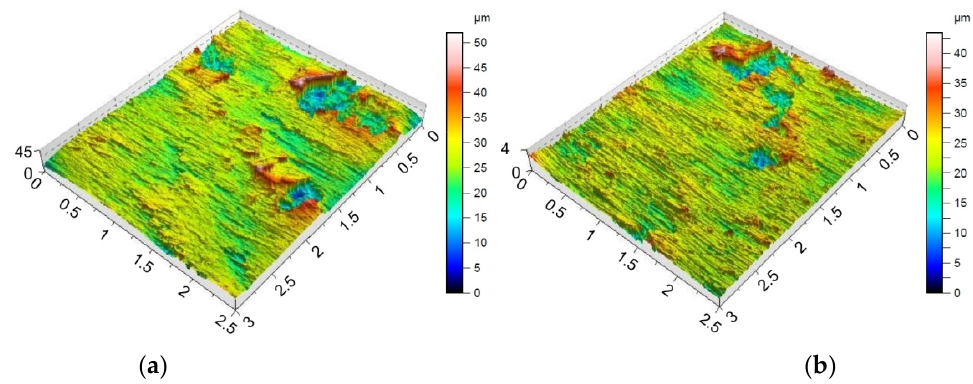
Figure 6. Topography of inside surface of the drawpieces formed at a p = 0.3 mm, f = 1250 mm/min, n = 789.64 rpm and toolpath strategy: ( a ) conventional and ( b ) climb.